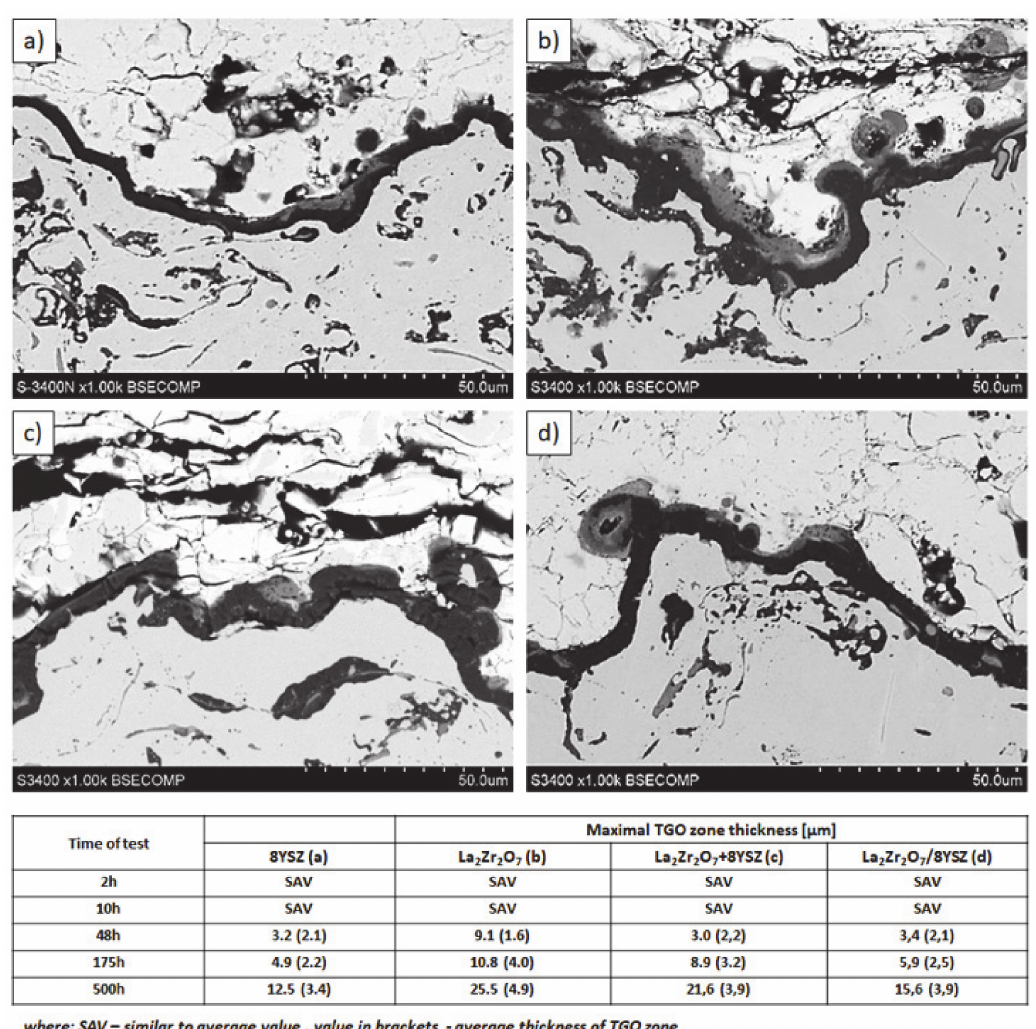
Figure 25. Quantitative description of the TGO zone thickness as a function of oxidation time: ( a ) 8YSZ monolayered TBC, ( b ) monolayered La 2 Zr 2 O 7 , ( c ) composite 50% La 2 Zr 2 O 7 + 50% 8YSZ, and ( d ) DCL La 2 Zr 2 O 7 / 50% La 2 Zr 2 O 7 + 50% 8YSZ /